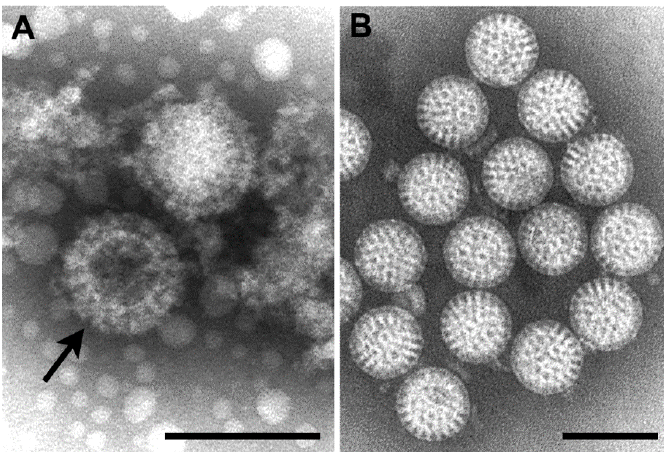
Figure 2. ( A ) Negative stain EM image of orthoreovirus particles, with a stain-penetrated particle (arrow) showing the double capsid layers; ( B ) Negative stain EM image of rotavirus particles. Bars, 100 nm. (Figure B, courtesy of Charles D. Humphrey, Centers for Disease Control and Prevention, Atlanta, GA,